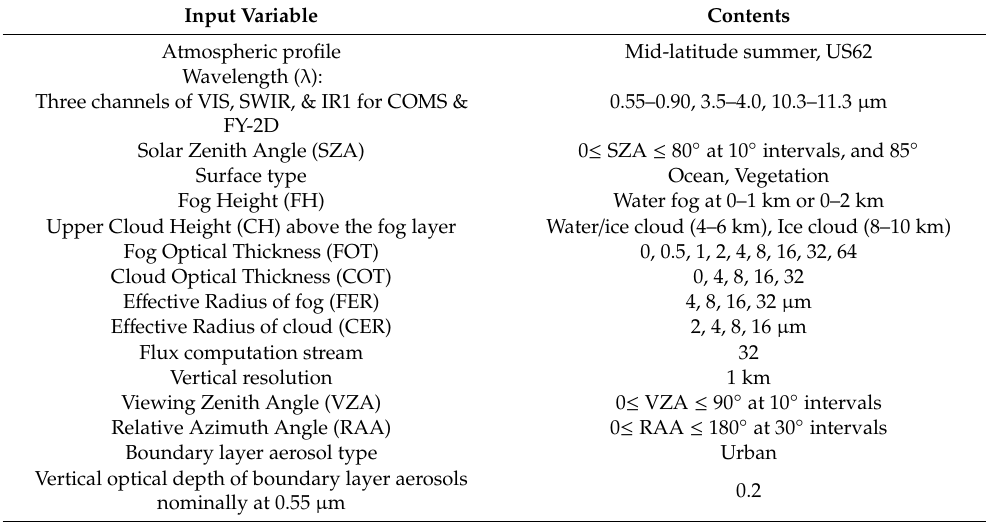
Table A4. SBDART input variables for the LUT